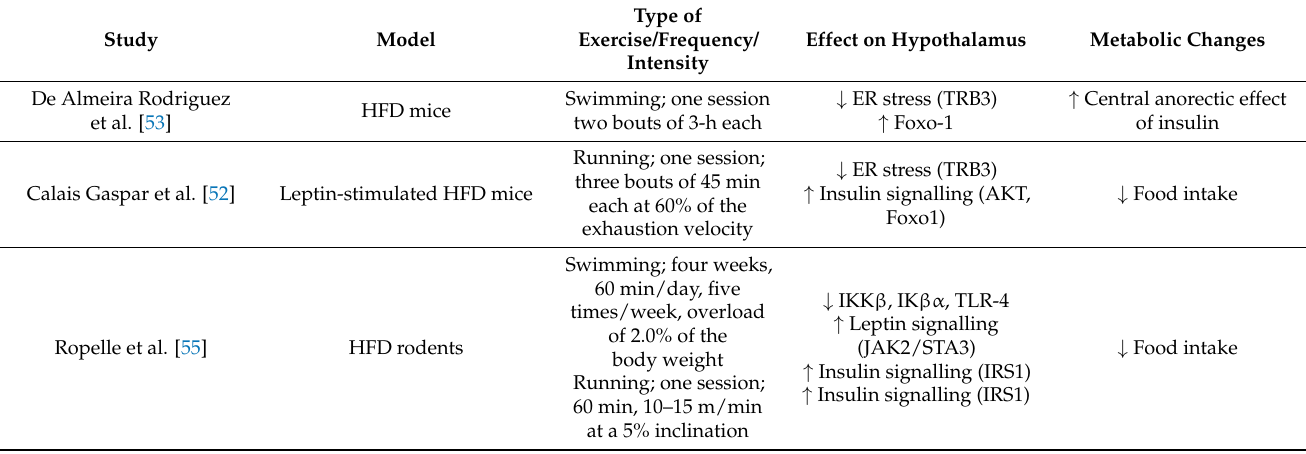
Table 1. Effect of exercise on hypothalamic inflammation and dysfunction in rodent models of